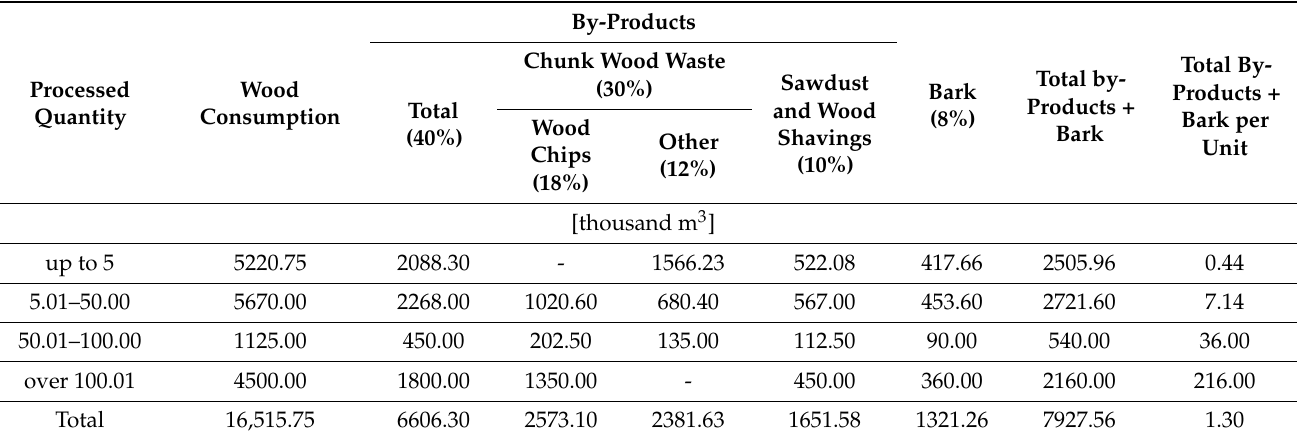
Table 7. Quantity of by-products generated by sawmills during wood processing.